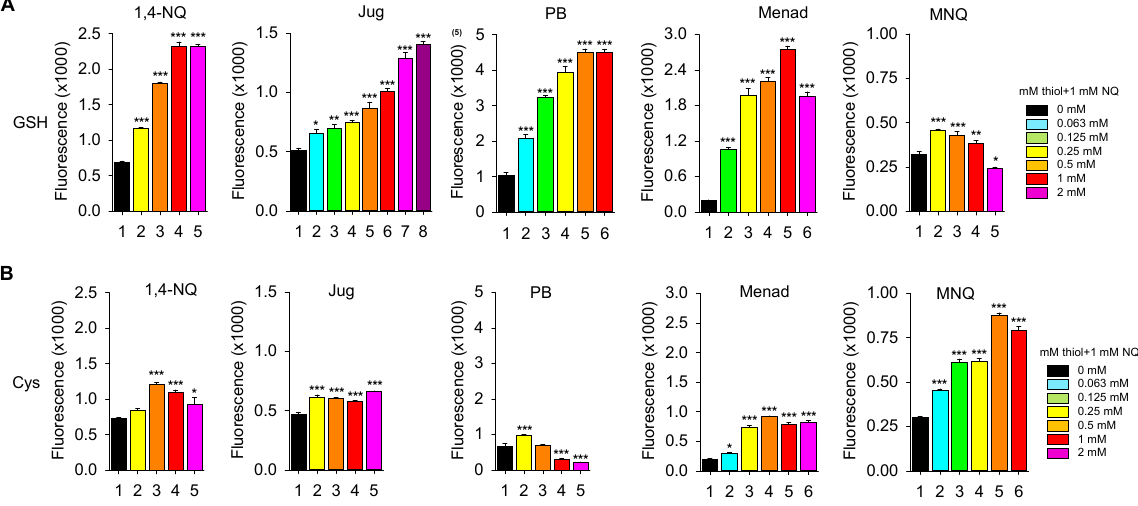
Figure 7. Effects of the ratio of GHS or Cys to NQ on polysulfide production (SSP4 fluorescence). A total of 1 mM of NQ was incubated with various concentrations of GSH ( A ) or Cys ( B ) for 1 h, diluted